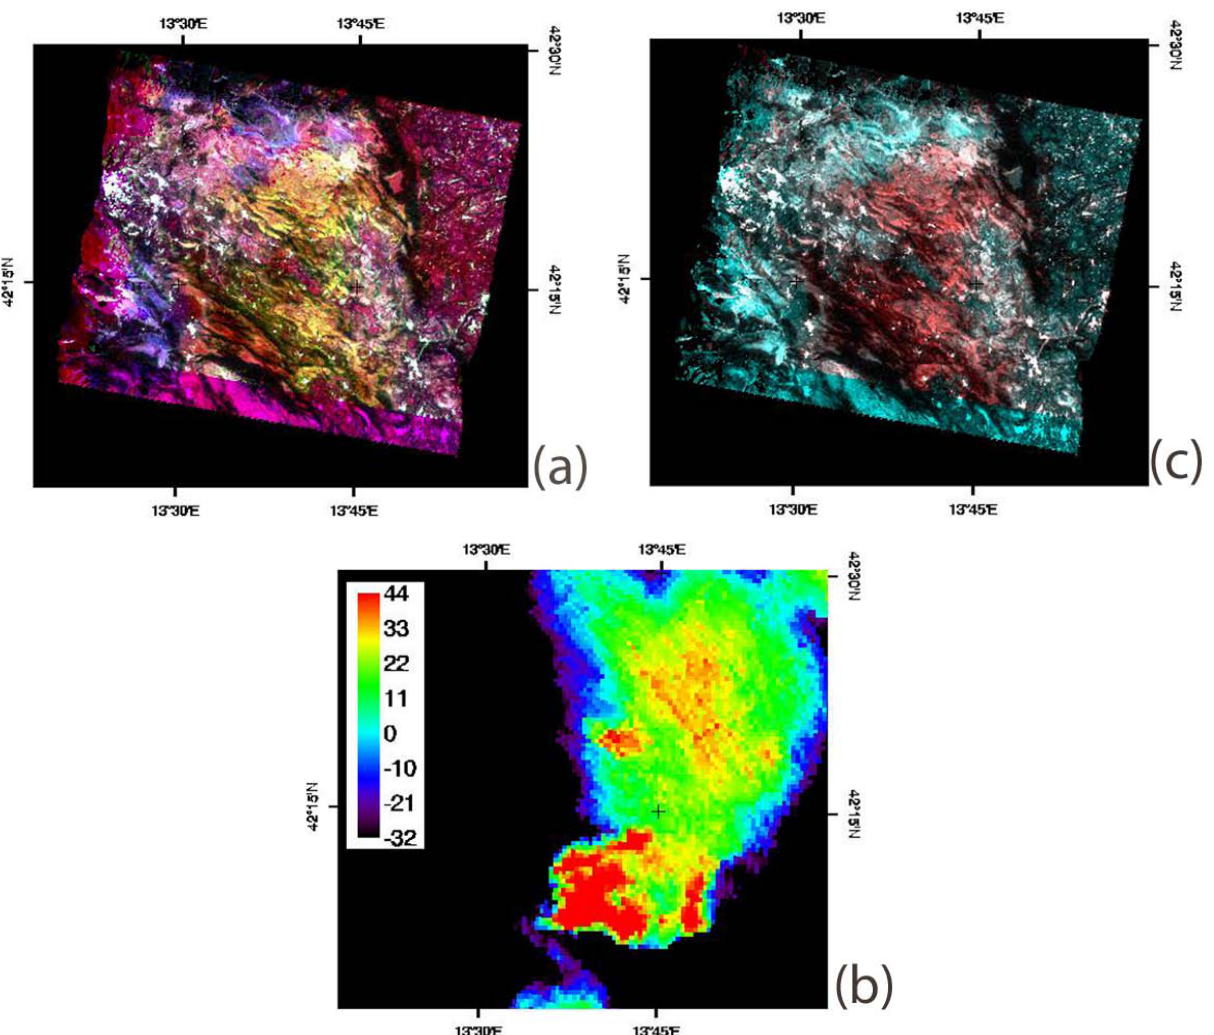
Fig. 6. Case study using CSK data over central Italy. (a) Three geocoded phase coherence images are shown in an RGB color com- position: red= cc 10 − 11 , Green= cc 10 − 27 and Blue= cc 11 − 18 . (b) Precipitation map of the same area as observed by the C-band Mt. Midia weather radar in terms of reflectivity factor Z (dBZ). (c) RGB composite of two geocoded phase coherence images (Red= cc 10 − 27 , Green=Blue= cc 11 − 18 ) .